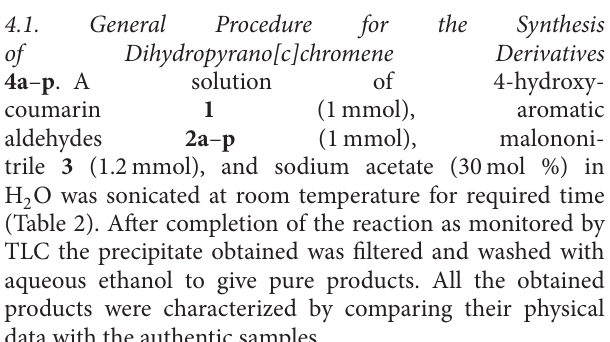
(Table 2). Aer completion of the reaction as monitored by TLC the precipitate obtained was �ltered and washed with aqueous ethanol to give pure products. All the obtained products were characterized by comparing their physical data with the authentic